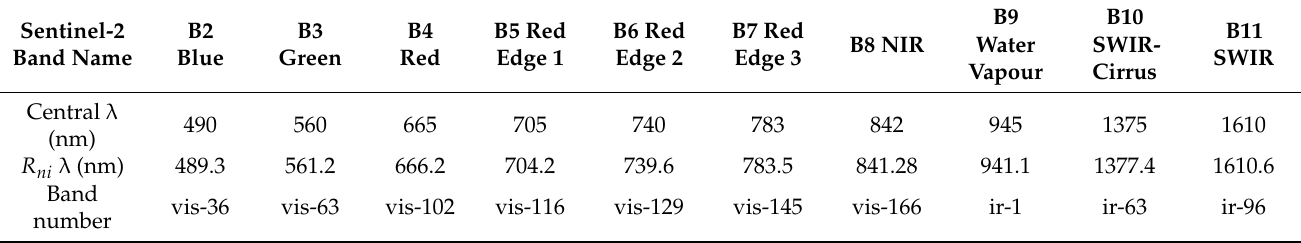
Table 2. Summary of Sentinel-2 bands and the closest wavelengths in the hyperspectral dataset with their band index number. Sentinel-2